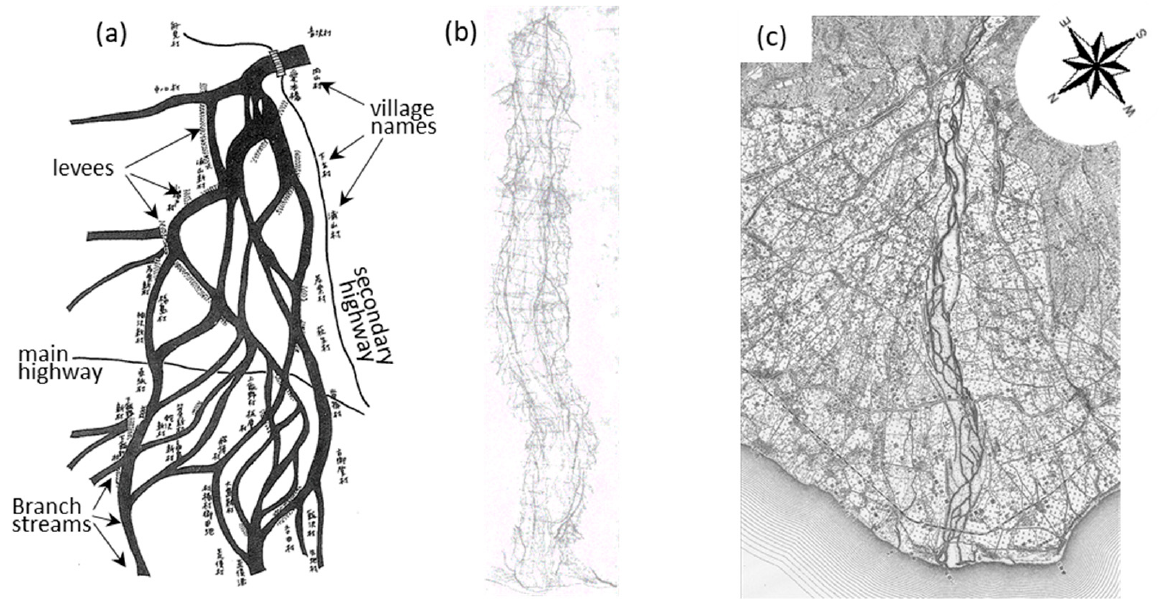
Figure 3. Old maps used in this study. ( a ) Pictorial map drawn in 1785; ( b ) levee lines measured in 1894; ( c ) 1/50,000 scale map published in 1910.